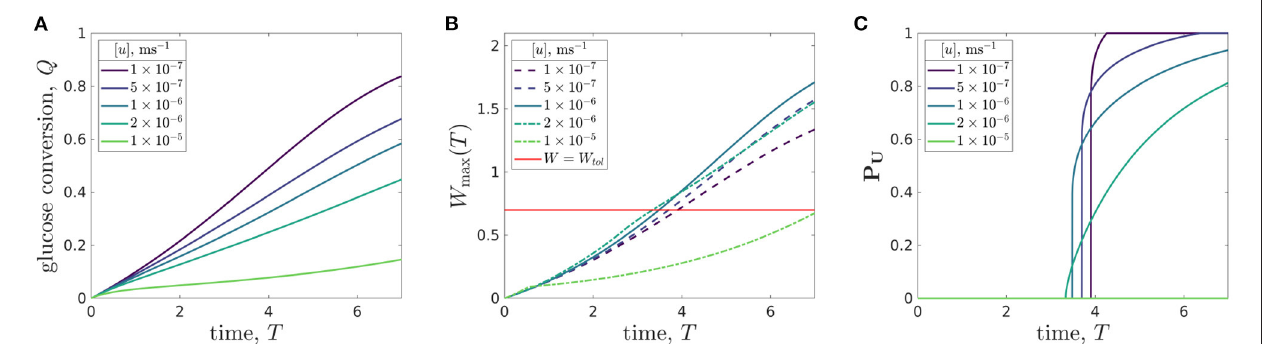
FIGURE 8 | Results for a specific organoid line within the CXP1 bioreactor showing the evolution of: (A) glucose conversion Q , Equation (3.3), (B) maximum lactate concentration W max ( T ), Equation (3.2), where the red line respresents the maximum tolerated lactate concentration, W = W tol , and (C) proportion of domain which is uninhabitable at time T , P U , Equation (3.4), against time for five different flow rates. For [ u ] = 10 − 5 ms − 1 , the value of P U is zero. The peak flow velocities [ u ] ∈ { 10 − 7 ,5 × 10 − 7 ,10 − 6 ,2 × 10 − 6 ,10 − 5 } ms − 1 used correspond to the dimensionless flow velocity parameter µ ∈ { 0.096,0.48,0.96,1.92,9.6 } , respectively. Remaining parameter values: see Table 3